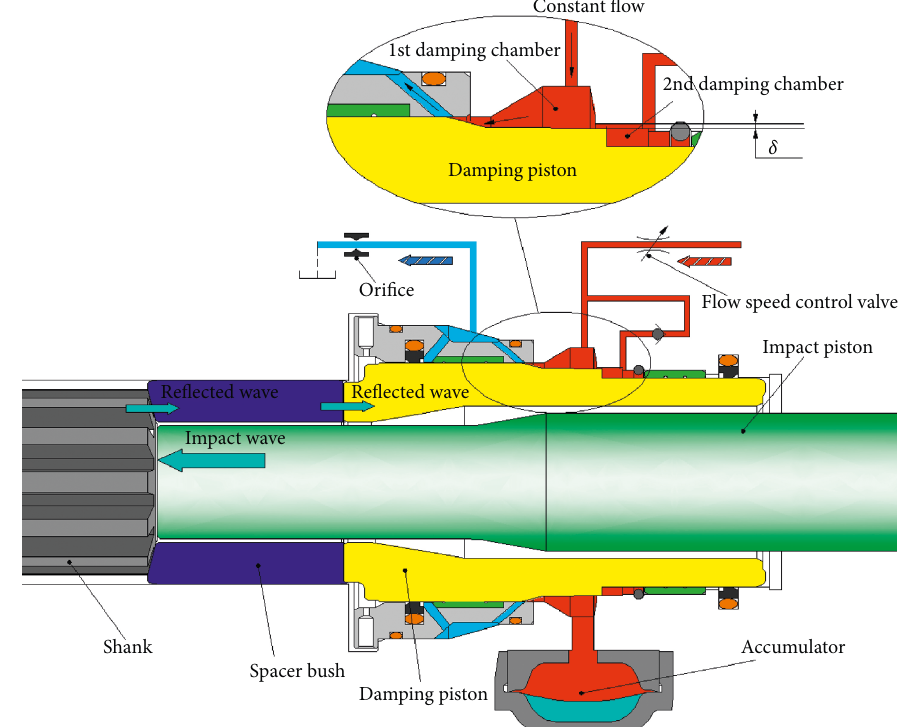
Figure 2: Working principle of the double damping system.